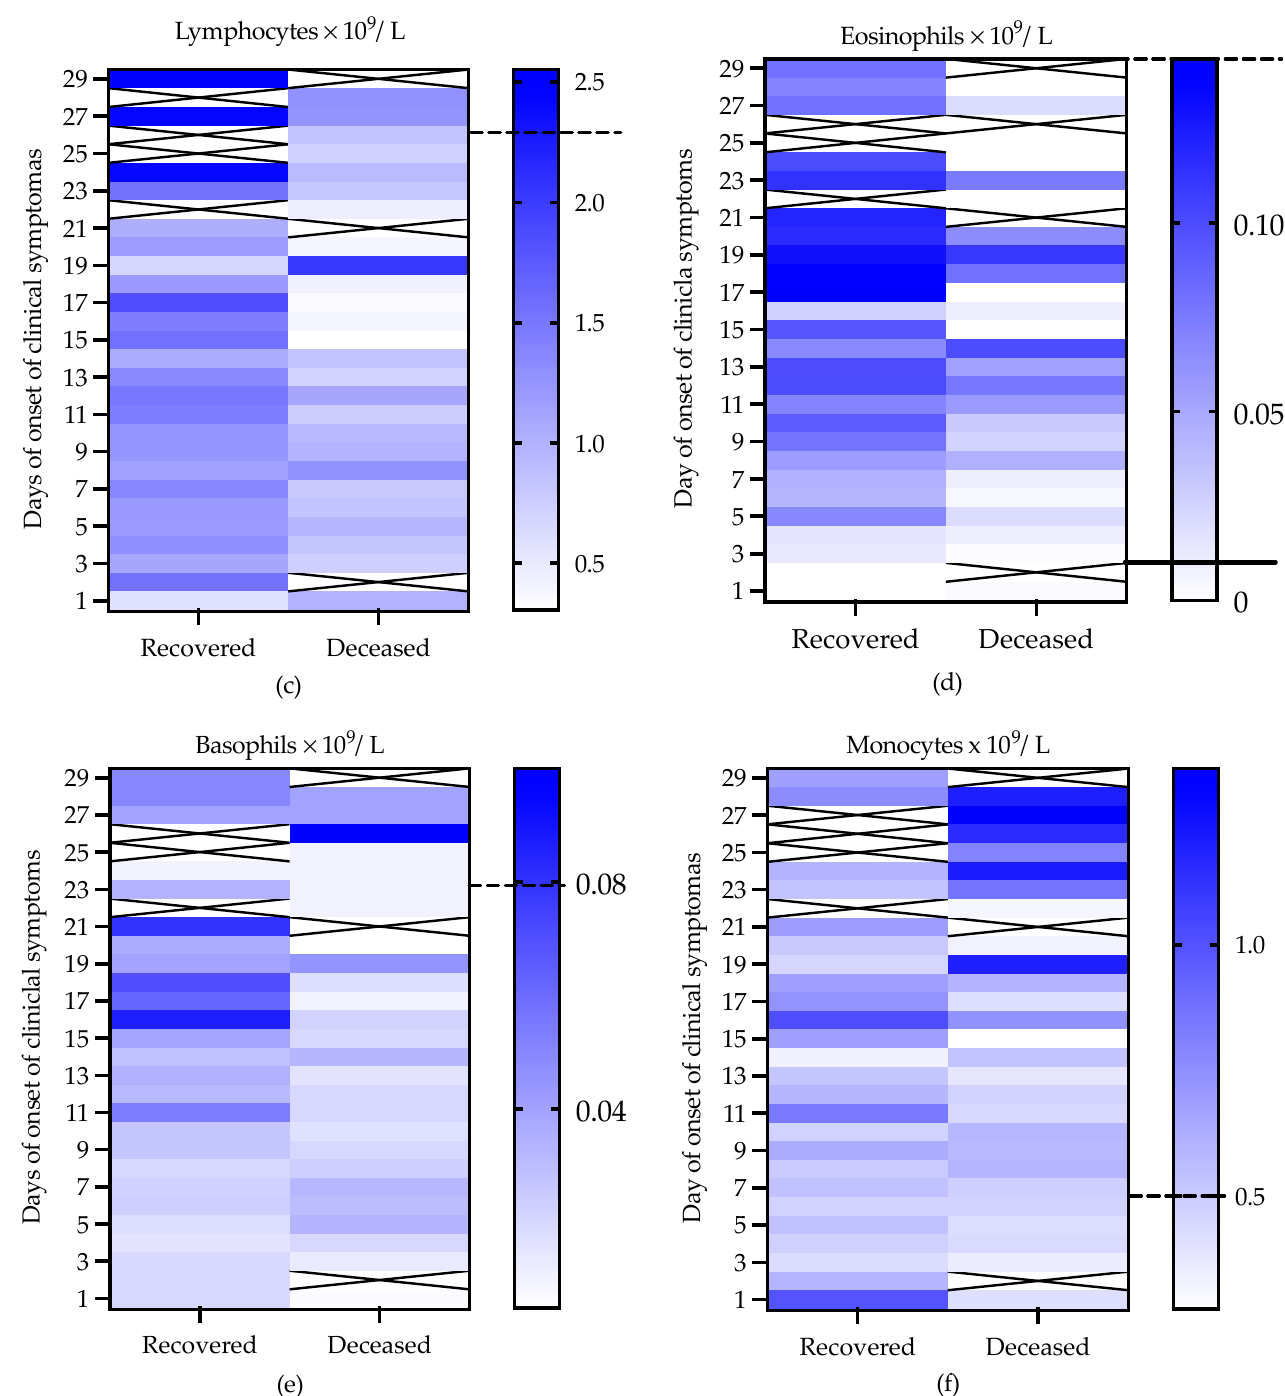
Figure 3. Behavior of ( a ) neutrophil-to-lymphocyte ratios (NLRs) and ( b – f ) white blood cell (WBC) differential counts in COVID-19 patients with different outcomes over the course of the disease. The dashed lines indicate the means of normal values of NLR or leukocytes. The continuous line in ( d ) delimits the value for eosinopenia.